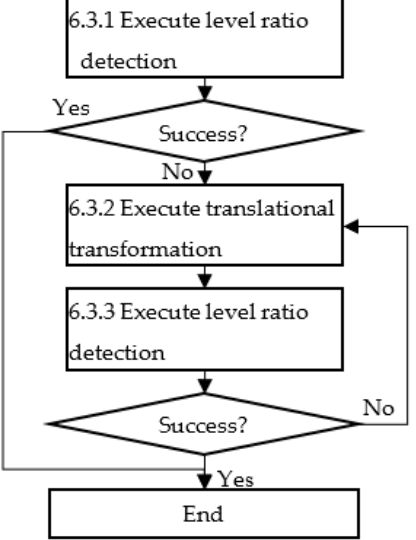
Figure 4. Flow Chart of Level Ratio Detection.